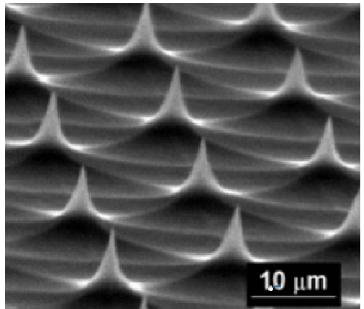
Figure 25. SEM of silicon tip-shaped metasurface, reprinted by permission from Springer Nature: Applied Physics A: Materials Science and Processing [217], Copyright